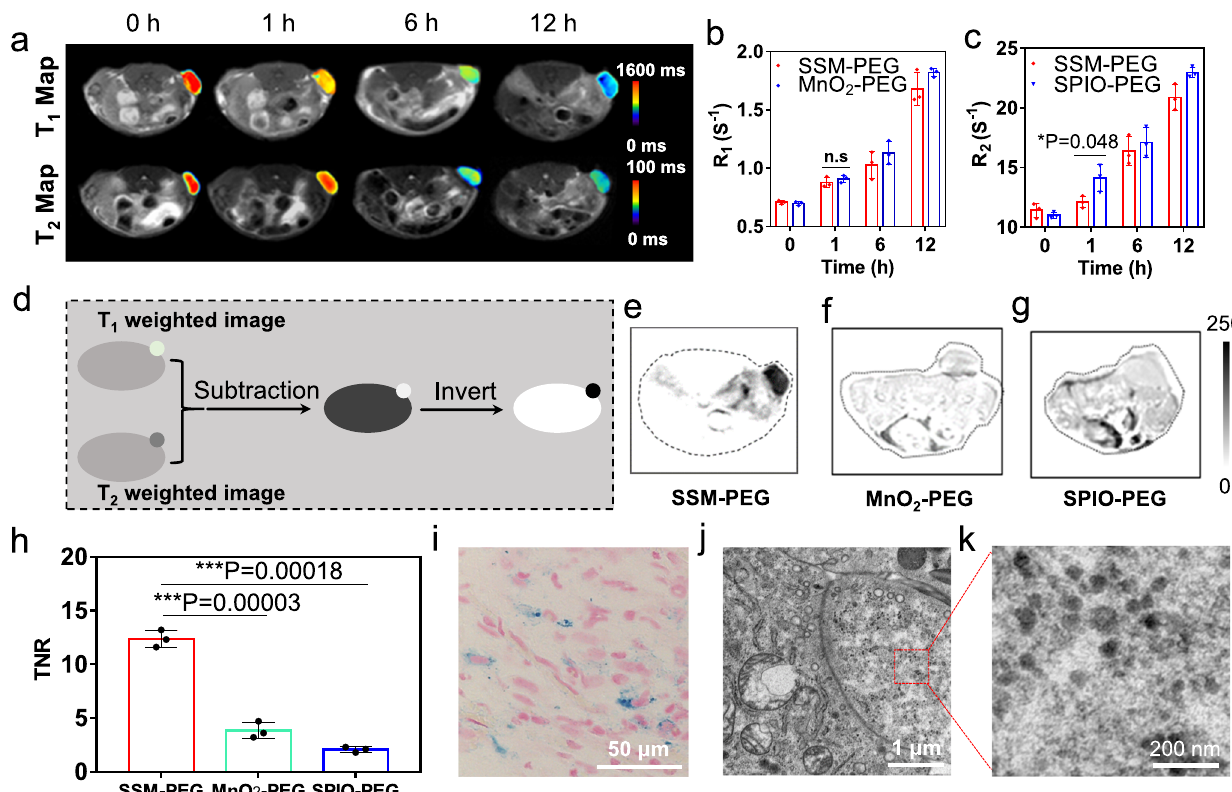
Fig. 5 | SSM-PEG (PEG-modi fi ed SPIO@SiO 2 @MnO 2 ) for in vivo MRI of 4T1 xenografttumor-bearingmice.a T 1 andT 2 Map, b R 1 ,and c R 2 atthetumorsiteof the 4T1-bearing mice. The I.V. injections of SSM-PEG and MnO 2 -PEG were given a dosageof5mg/kg,andtheMRIdiagnosiswasperformedatdifferenttimepointsat 0,1,6,and12hposttheinjection.T 1 andT 2 Maparerepresentativedatafromthree mice samples. R 1 and R 2 Data are presented as mean±SD from three independent mice samples. d Illustration of the Dual-contrast-Enhanced Subtraction Imaging (DESI) procedures; T 1 and T 2 dual-modal MRI images were processed by DESI methodofthetumor-bearingmiceat12haftertheinjectionof e SSM-PEG,fMnO 2 -